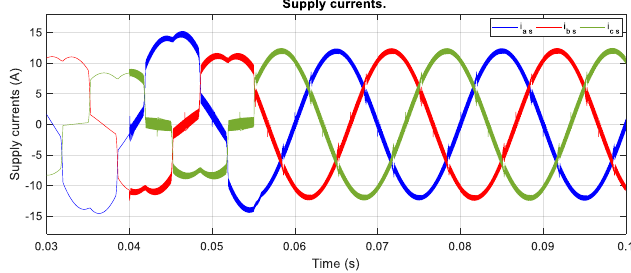
Figure 13. Current tracking error during detail 2 time interval.